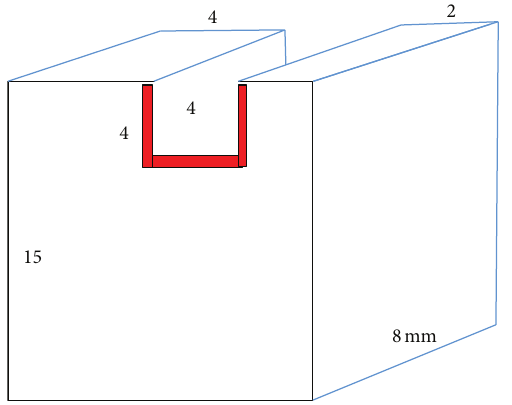
Figure 2: Geometry of cusp deformation block and its cavity. Standard cavity depth of 4mm has been presented.